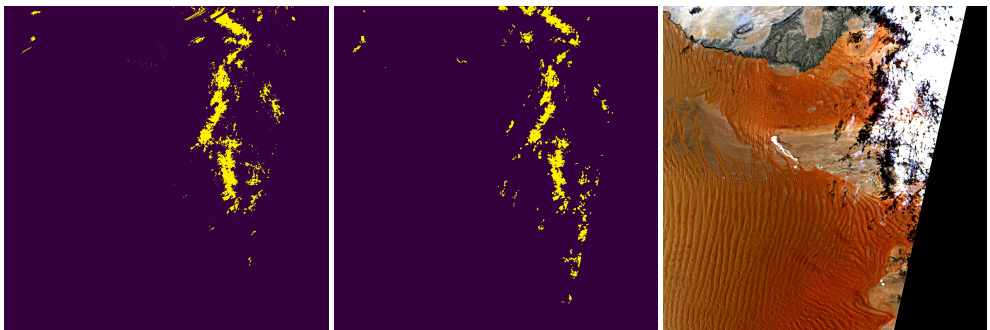
Figure 1. Gobabeb shadow map. Left: cloud shadow map of ATCOR; middle: TIP cloud shadow map; right: Gobabeb RGB = 665/560/490 nm with linear histogram